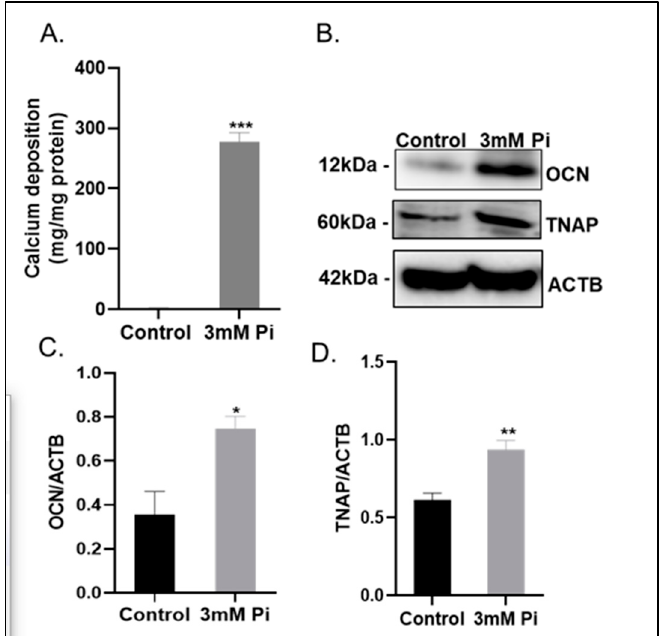
Figure 1. Calcification of VSMCs in vitro. ( A ) Calcium content (mg/mg protein) of VSMCs (n = 6). ( B ) Representative image of immunoblotting and associated density quantification of ( C ) Osteocalcin (OCN) (n = 3) and (D) tissue-nonspecific alkaline phosphatase (TNAP) (n = 3) protein expression compared with ACTB ( β -actin). Data shown as mean +/ − S.E.M * p < 0.05; ** p < 0.01; *** p < 0.001 compared to